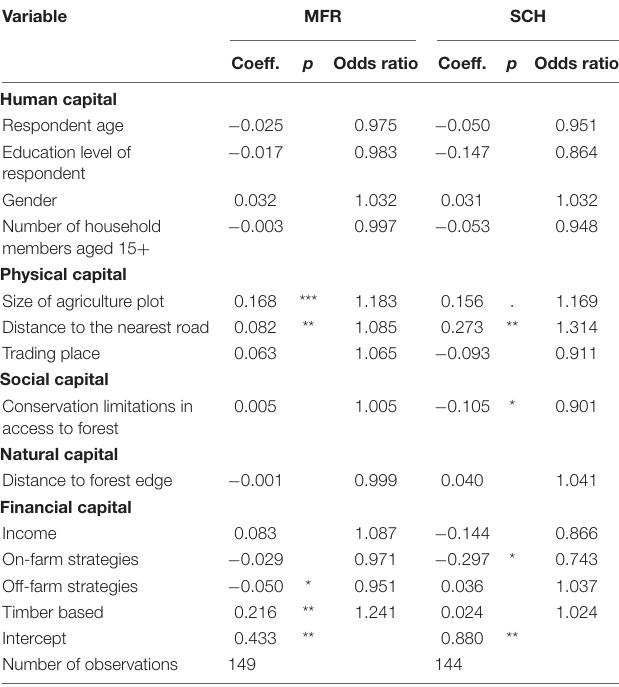
TABLE 8 | Estimation results of logit regression for deforestation at households’ level by study areas, MFR and SCH.